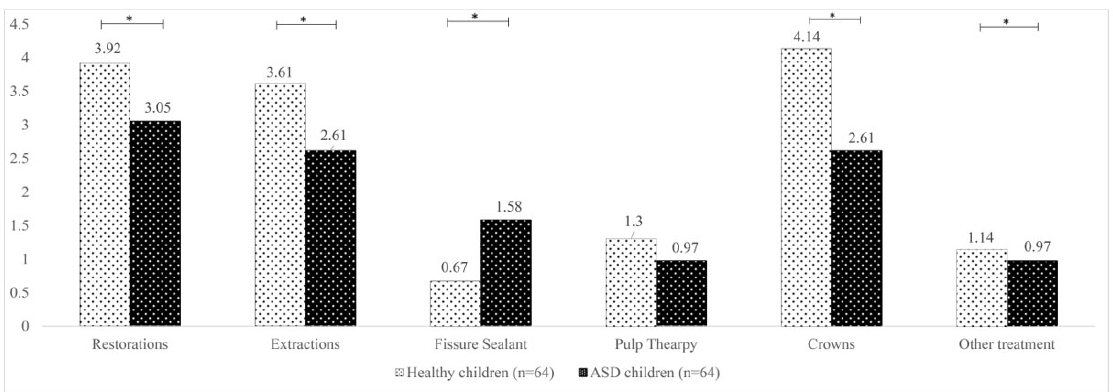
Figure 2. Comparison of the dental procedures under general anesthesia between children with autism spectrum disorder and healthy-matched children (mean values are displayed). * Statistically significant.